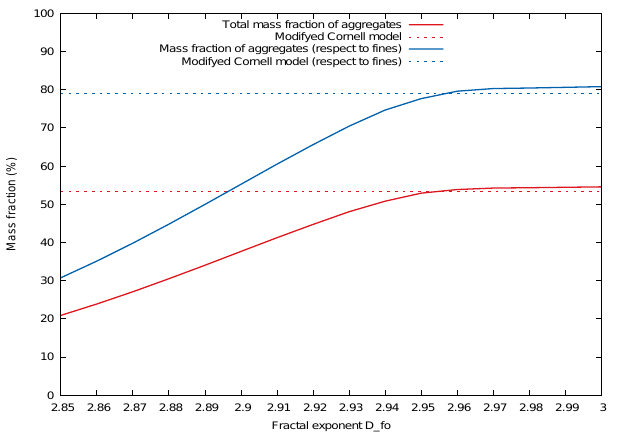
Figure 6. El Chichón 1982 phase-B simulation. Total mass fraction of aggregates (red line) and total mass fraction of aggregates with respect to fines (blue line), depending on the fractal exponent D fo . The (constant) values predicted by the modified Cornell model are shown by dashed lines.